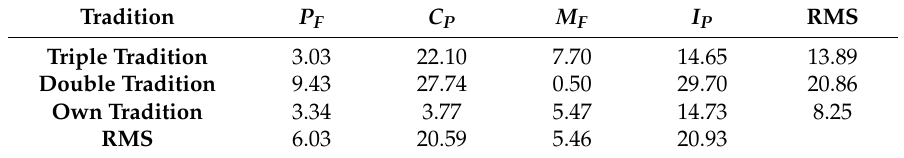
Table 16. Confidence levels (%) for the indicated Traditions (only Matthew and Luke).